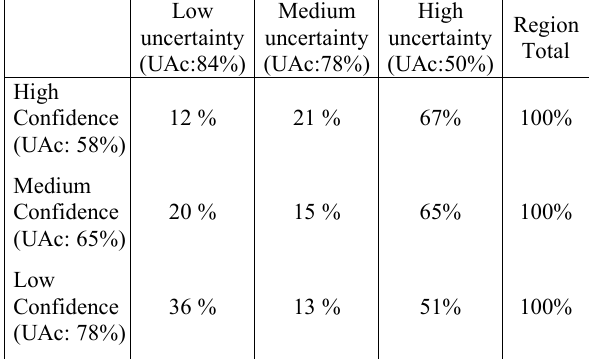
Table 4. Percentage of the pixels classified as